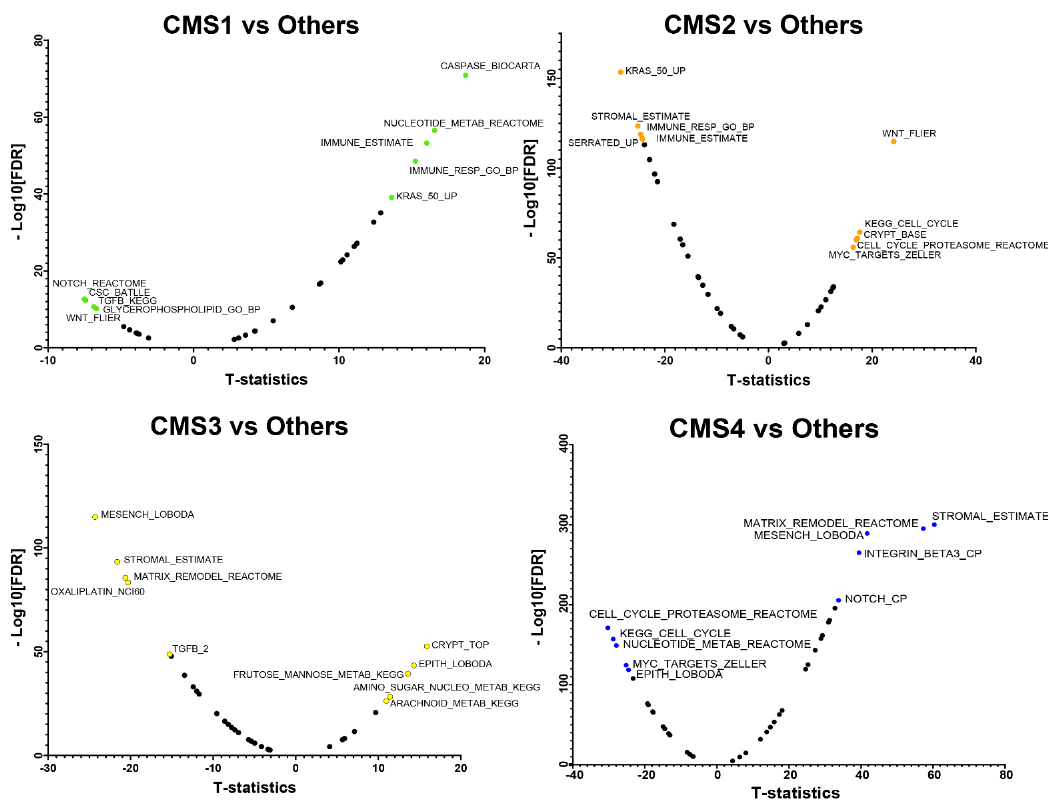
Figure 2. Volcano plots of CMS-specific marker gene sets (total = 83). The top five and bottom five most significant, over- and under-enriched gene sets in each CMS tumor sample are annotated in each volcano plot. 3.3. CMS Represents the Transcriptomic Inter-Tumor Heterogeneity of Colorectal Cancer There were 27 non-redundant gene sets identified from the over-enriched (top five) and the under-enriched (bottom five) marker gene sets of each CMS group (Table S1). The NESs of these non-redundant gene sets across the 3232 CRC tissue samples were trans- formed to Z-scores and are shown in a heatmap plot (Figure 3a). The hierarchical cluster- ing of gene sets indicates that CMS1-, CMS2-, CMS3-, and CMS4 tumors had homogene- ous activations in their respective signature gene sets/pathways. For example, in the clus- ter of CMS2 tumor samples, activations of classical oncogenic signaling pathways such as Wnt, Myc, and cell cycle were observed; CMS4 tumors showed activation of stromal-, ma- trix-remodeling-, and mesenchymal gene sets. CMS1 tumors showed homogeneously ac- tive immune-response- and caspase pathways, and CMS3 tumors were enriched with ac- tive metabolic pathways. These results recapitulate the known ability of the CMS frame- work to identify inter-tumor differences in tumor biology among CRC patients [19]. In contrast, the NESs of all 27 transcriptomic signature gene sets within the mixed group of CRC samples were highly heterogeneous, indicating that these tumors had multiple ac- tive, transcriptomic signatures that did not align with a single CMS (Figure 3a). In uniform manifold approximation and projection (UMAP) of all 3232 CRC tumors, the mixed sub- type did not form a distinct cluster; rather, the mixed samples aligned within the clusters of the other four CMSs (Figure 3b). This projection showed that CMS1 and CMS4 tumors tended to form distinct clusters, whereas there was not separation between CMS2 and